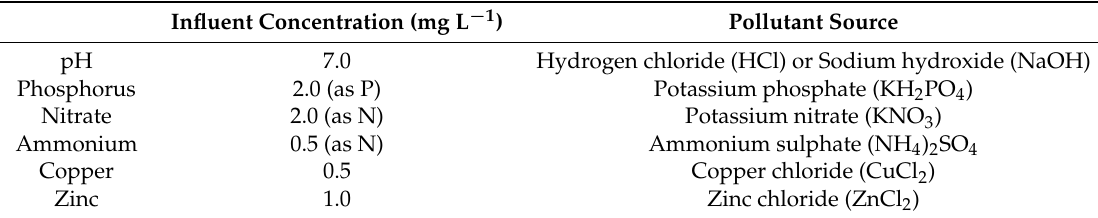
Table 1. The characteristics of the synthetic storm runoff in this